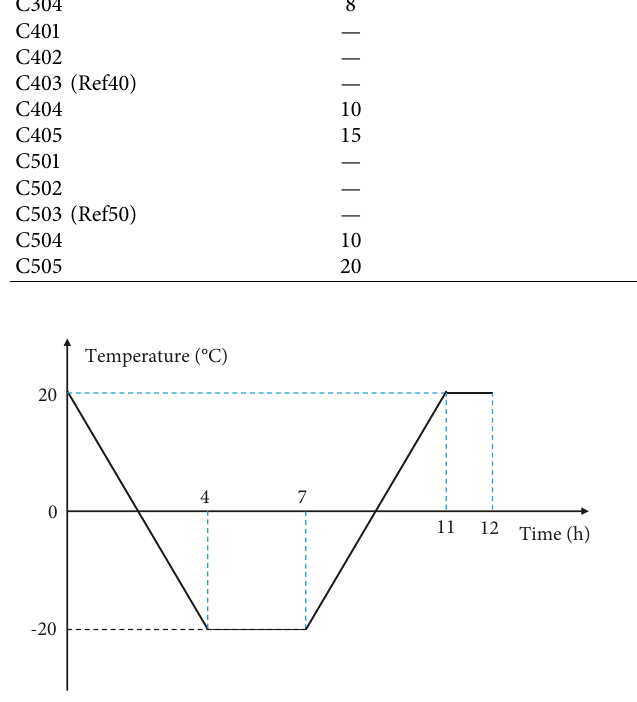
Figure 2: F-T cycling scheme of salt freezing